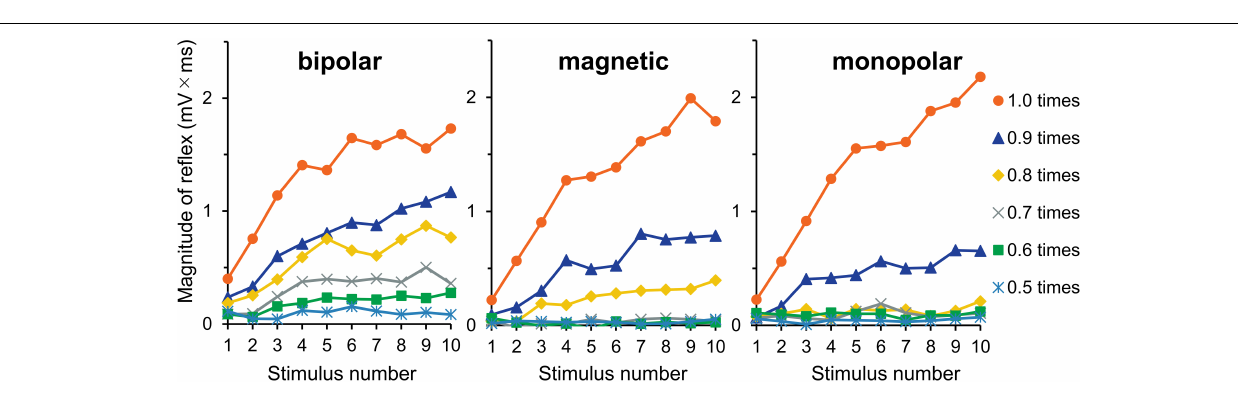
FIGURE 5 | Experiment 3. The reflex magnitude for 10 consecutive stimulations at six stimulation